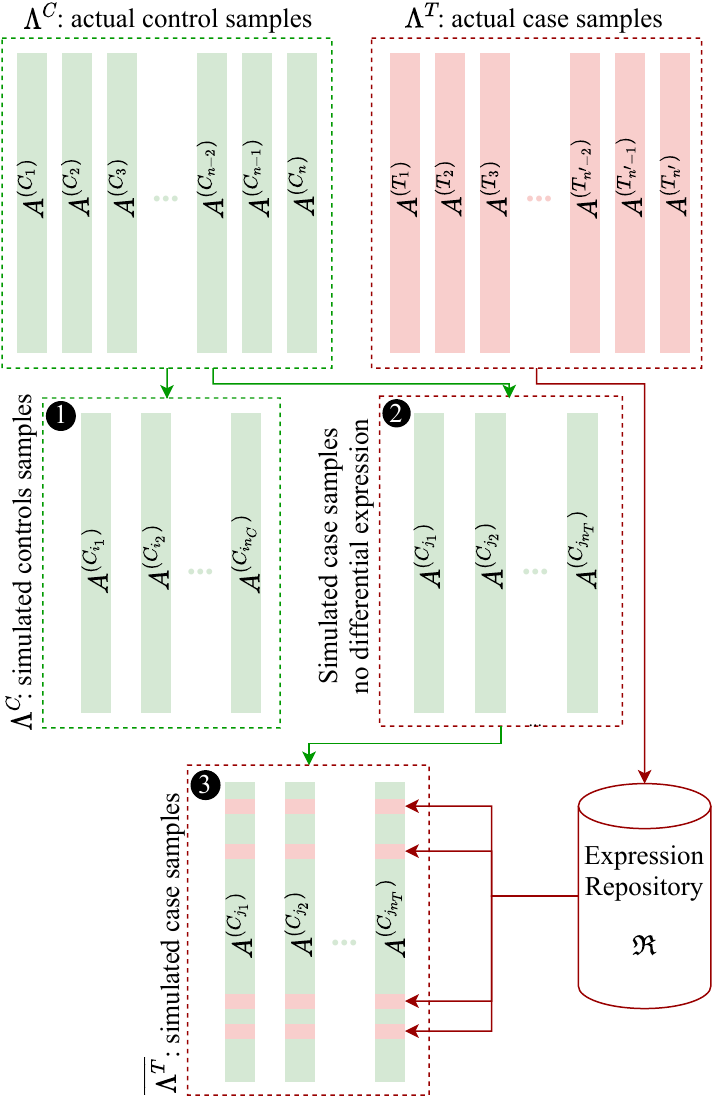
Figure 1. Visualization of the methodology used by Silver to synthesize expression datasets. The control samples ( Λ C ), and the case samples ( Λ T ) of the original dataset are shown in green and ( C inC ) } red, respectively. To simulate control samples, Silver uses a subset Λ C = { A ( C i 1 ) , . . . , A of original control samples shown in box 1. To simulate case samples, Silver also uses another ( C jnT ) } subset Λ T = { A ( C j 1 ) , . . . , A of control samples shown in box 2. Silver creates a repository of real expression values (cid:60) by sampling from the original cases from Λ T . The repository (cid:60) can be considered as a table of expression measures with n T columns, where n T is the desired number of cases to be simulated. Each row of (cid:60) contains n T measures sampled from one row of the actual cases Λ T . For a given gene, Silver simulates differential expression by finding expression measures that satisfy a criterion for differential expression of that gene and replaces the expression measures in the simulated cases (from box 2) for that gene in order to create new case samples shown in box 3. Criteria implemented for differential expression include t -test, Wilcoxon rank-sum test, and simple